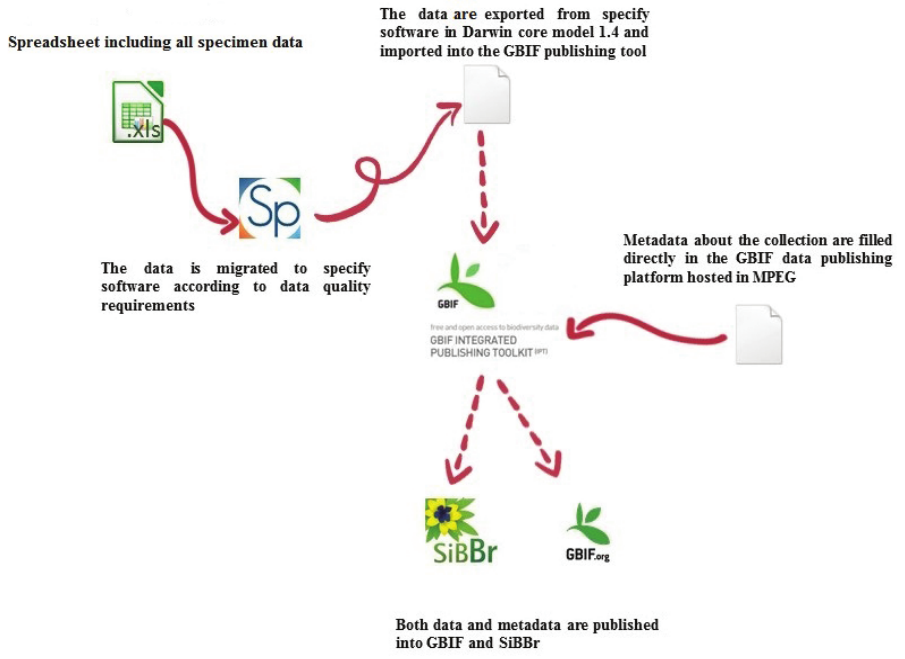
Figure 4. Flow chart of data publication process. Produced by the